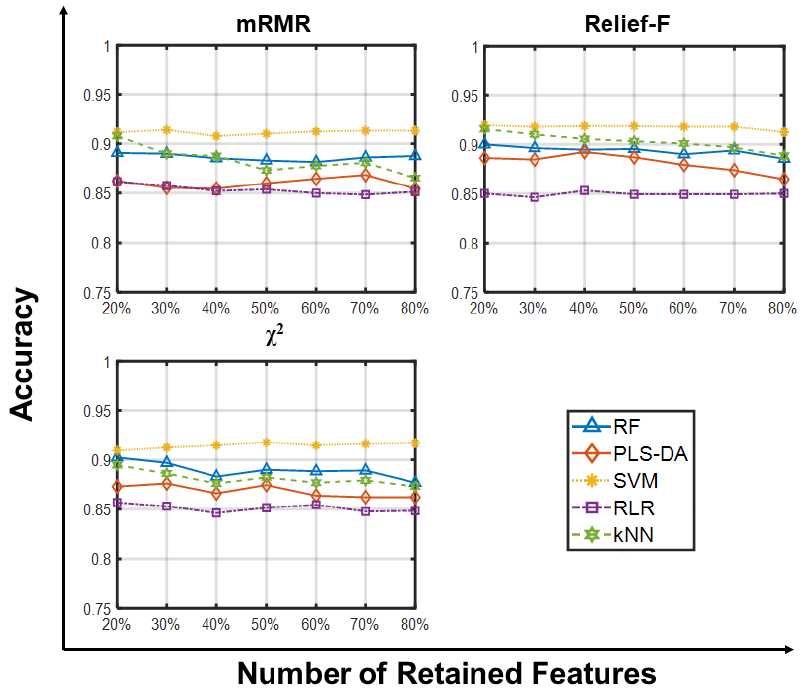
Figure 4. Predictive accuracy retaining larger sets of retained features on GLI_85. Predictive accuracies of RF, PLS-DA, SVM, RLR and kNN vs. Number of Retained Features (20, 30, 40, 50, 60, 70, 80% of the whole gene set) on the GLI_85 dataset using three feature selection methods. Each point is the average predictive accuracy computed over 100 resamplings.